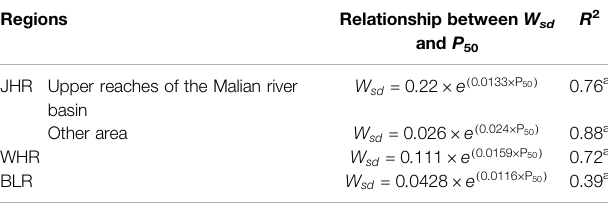
TABLE 5 | Relationships between W sd and P 50 of the JHR, WHR and